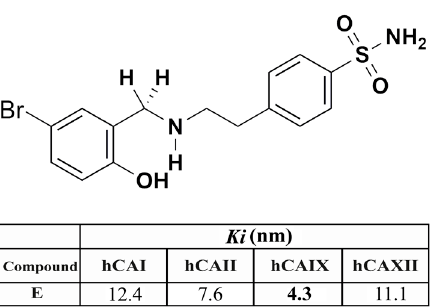
Figure 11. The chemical structure of compound E and inhibition data ( K i , nM, values) against the major human (h) CA isoforms I, II, IX, and